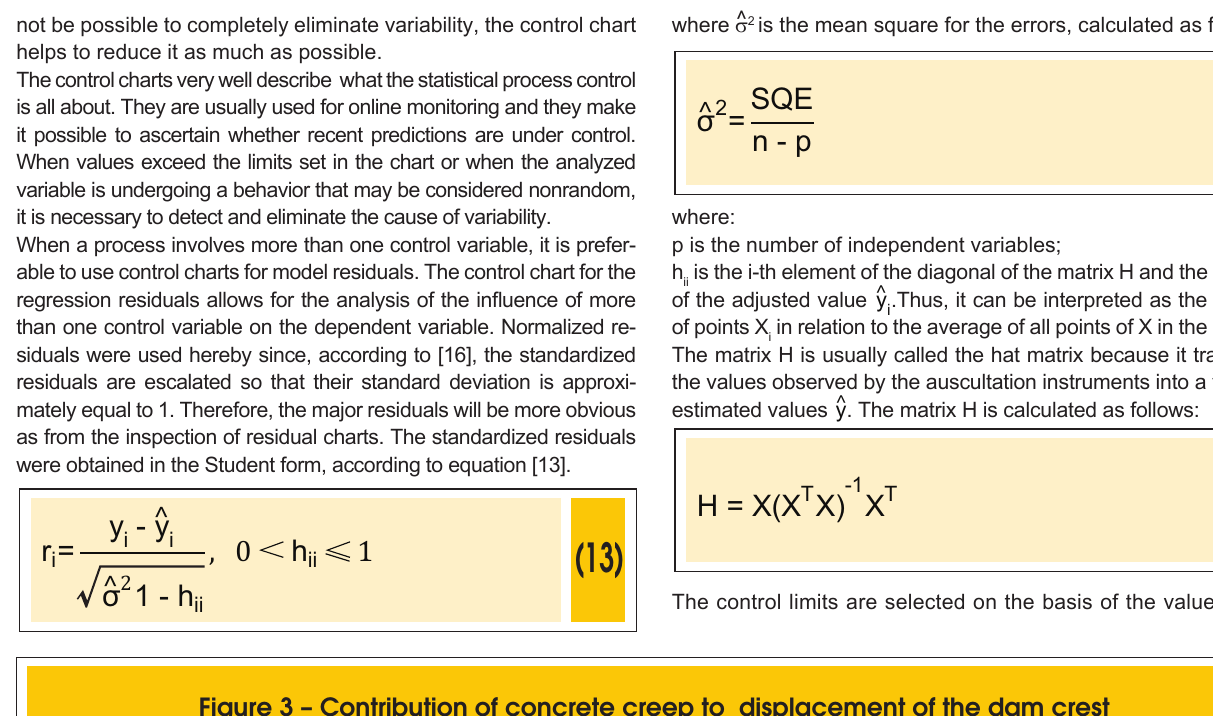
Figure 3 – Contribution of concrete creep to displacement of the dam